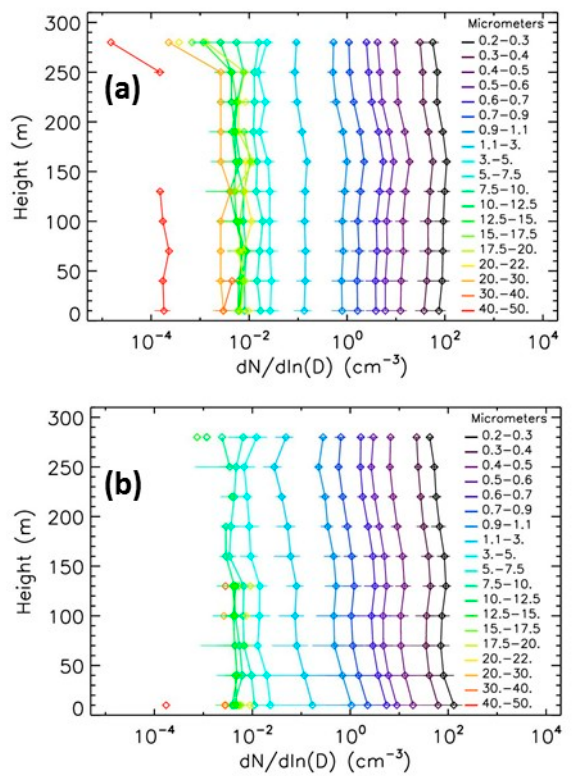
Figure 7. Evolution with height of number concentrations for the 19 size classes of LOAC when the urban pollution is low. ( a ) 8 July 2016; ( b ) 20 September 2017.